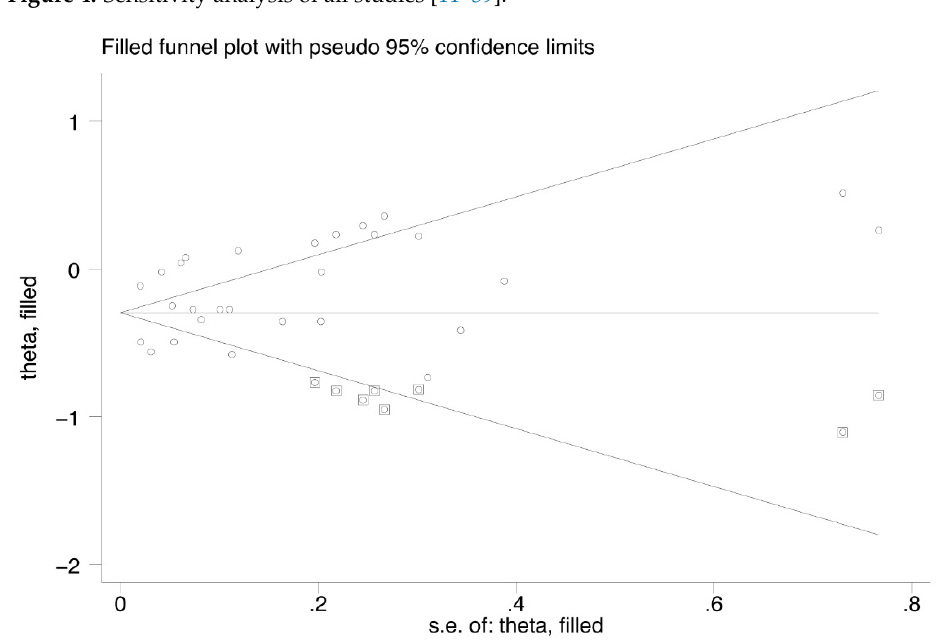
Figure 5. Funnel plot of nonparametric trim-and-fill method.